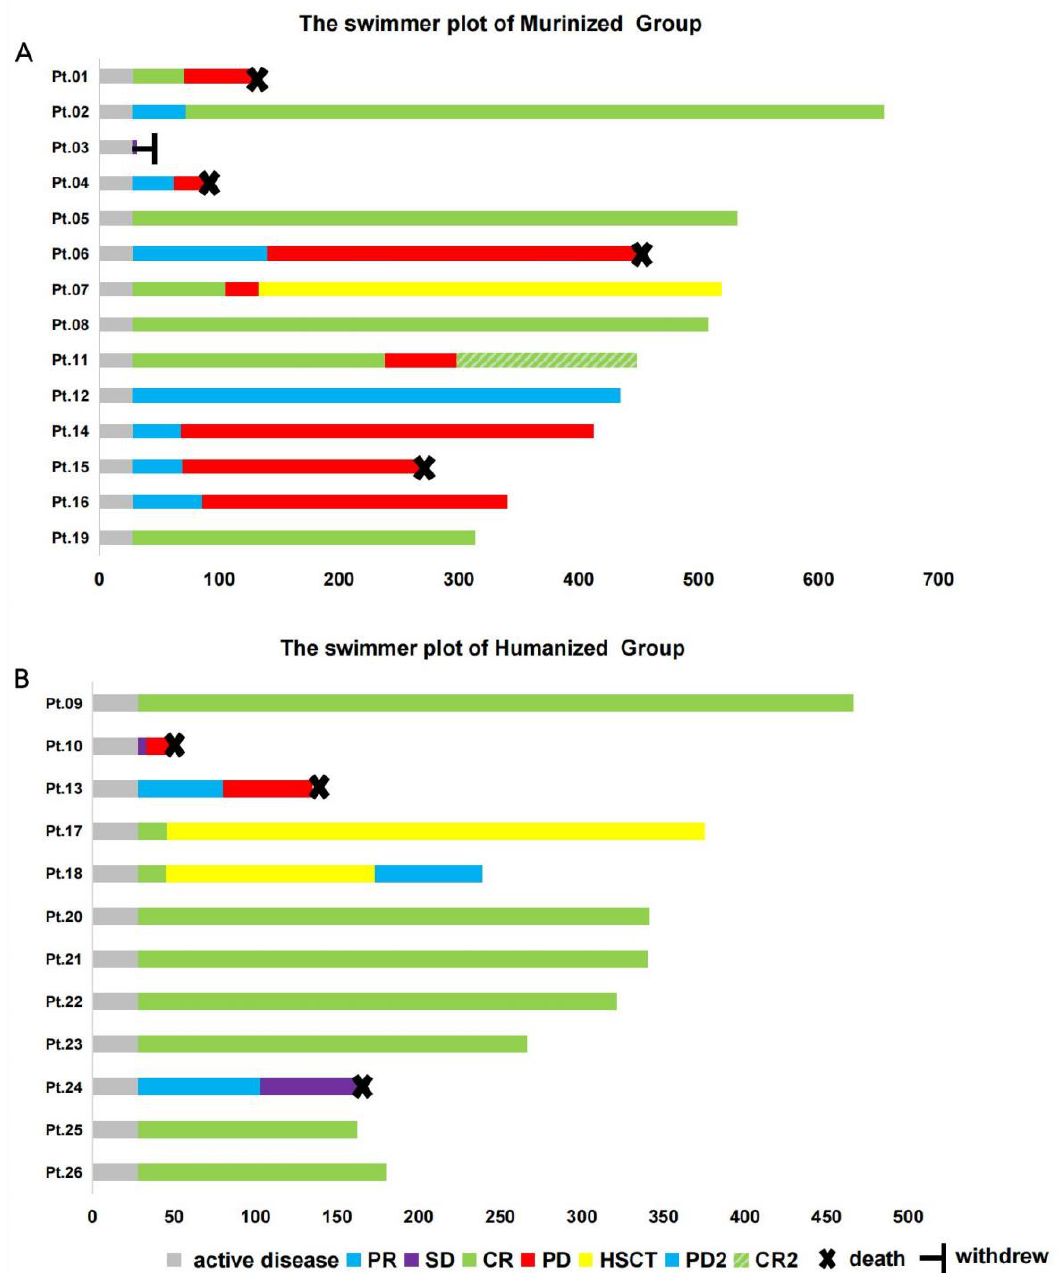
Figure 4. Clinical outcomes of the murinized and humanized group patients. The clinical outcomes post-murinization ( A ) and humanization ( B ). CD19/22 cocktail CAR-T infusions are shown in swimmer plots. Responses were confirmed and assessed according to the 2014 Lugano classification or the International Working Group Response Criteria for Malignant Lymphoma using PET/CT images evaluated by two expert nuclear medicine physicians. ( A ) Median follow-up time of the murinized group was 423 days (range: 31 – 654 days). Pt03 withdrew on day 31 due to a lack of response to CAR-T. Pt07 achieved CR on day 28, but relapsed on day 77, and later achieved CR again with radiotherapy combined with allo-HSCT. CR2 indicates achievement of CR again after PD. ( B ) Median follow-up time of the humanized group was 252.2 days (range: 47 – 466 days). Seven patients (Pt09, Pt20, Pt21, Pt22, Pt23, Pt25, and Pt26) had continued remission after CAR-T therapy. Two patients (Pt17 and Pt18) bridged to allo-HSCT after CAR-T therapy, 1 patient remained in CR post-HSCT, and the other relapsed on day 173. CR: complete response; PR: partial response; SD: stable disease; PD: progressive disease; allo-HSCT: allogeneic hematopoietic stem cell transplantation.